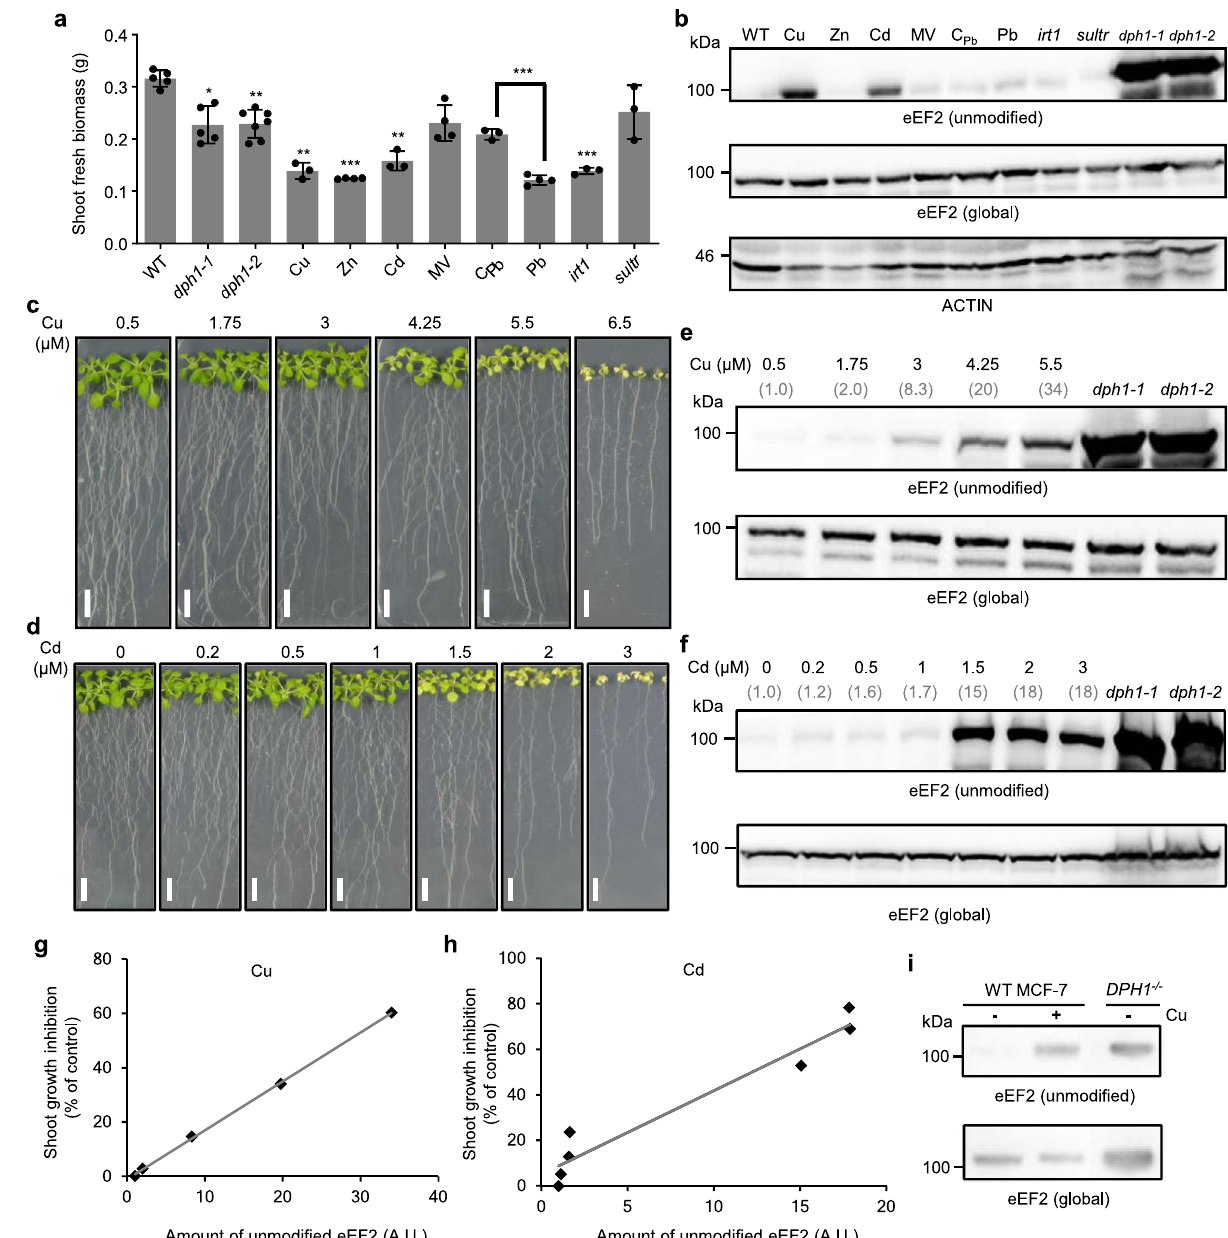
Fig. 5 Copper and cadmium toxicity correlate with accumulation of diphthamide-unmodi fi ed eEF2 protein. a Shoot fresh biomass of 18-day-old seedlings. Wild-type (WT; n = 5), iron uptake-defective irt1 ( n = 3), sulfate uptake-defective sultr1;1 sultr1;2 (sultr) ( n = 3), dph1-1 ( n = 5), and dph1-2 ( n = 7) mutants were cultivated in modi fi ed Hoagland medium. Additionally, WT was cultivated in modi fi ed Hoagland medium supplemented with 5 µ M Cu ( n = 3), 80 µ M Zn ( n = 4), 2 µ M Cd ( n = 3), 5 nM methyl viologen (MV; n = 4), 25 µ M Pb ( n = 4), and a speci fi c Pb-free control medium (C Pb; n = 3). Shown are mean ± s.d., n biologically independent pools of 17 seedlings, with each pool sampled from a replicate petri plate, from one experiment. * P < 0.05, ** P < 0.01, *** P < 0.001 (one-way ANOVA with Games-Howell test, or two-tailed Student ’ s t -test compared with the respective control). b Immunoblot detection of unmodi fi ed and global eEF2 protein in total protein extracts from shoot tissues of the seedlings shown in a . c , d Photographs of 18-day-old WT seedlings cultivated on series of CuSO 4 ( c ) or CdCl 2 ( d ) concentrations in modi fi ed Hoagland medium (Controls: 0.5 μ M Cu, 0 µ M Cd). Scale bars, 10 mm. e , f Immunoblots (as in b for shoots of Cu-exposed ( e ) and Cd-exposed seedlings ( f ), respectively. Numbers indicate the fold increase in unmodi fi ed eEF2 protein amount relative to controls, after normalization to global eEF2 protein levels. Protein extracts from dph1-1 and dph1-2 seedlings served as controls. g , h Relationships between the amount of unmodi fi ed eEF2 protein and shoot growth inhibition in Cu-exposed ( g , y = 1.80 x − 1.15, R ² = 0.9995) and Cd-exposed ( h , y = 3.68 x + 5.00, R ² = 0.9384) WT seedlings. A.U. arbitrary units. i Immunoblot detection of unmodi fi ed and global eEF2 protein in total protein extracts from DPH1 − / − mutant and WT of human MCF-7 cell line cultivated in liquid medium without or with addition of 125 μ M CuSO 4 for 3